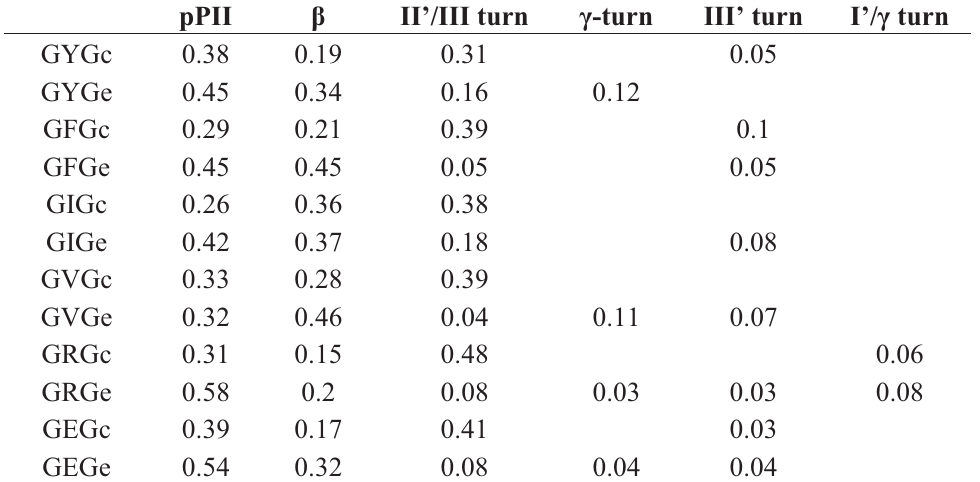
Table 1. Comparison of Conformational Distributions of the Indicated GxG Peptides in Solution (Water) and in Truncated Coil Libraries [174]. Subset “c” represents those obtained coil libraries, subset “e” represents experimentally obtained distributions. pPII (cid:2) II’/III turn (cid:3)-turn III’ turn I’/(cid:3)